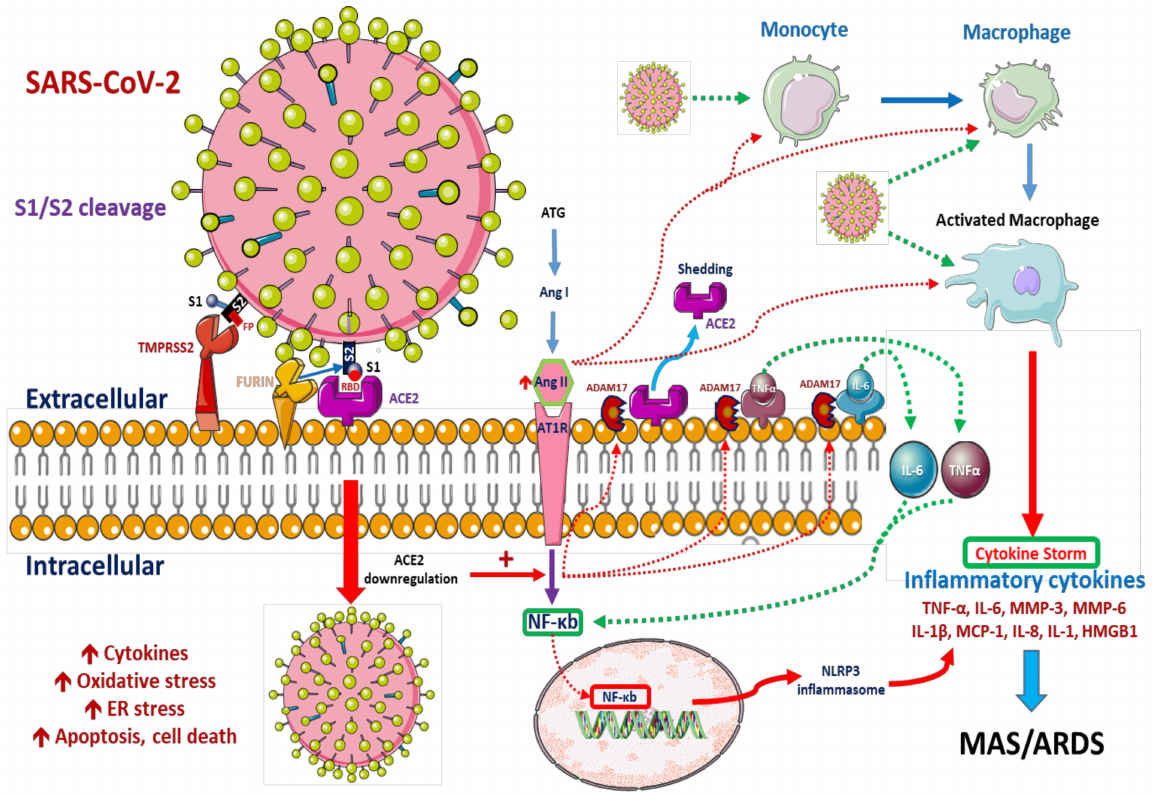
Figure 1. Possible pathophysiological pathways after the entry of severe acute respiratory syndrome coronavirus 2 (SARS- CoV-2). SARS-CoV-2 infects both alveolar macrophages and type II alveolar cells by binding to angiotensin-converting 2 (ACE2) receptors. Before SRAS-CoV-2 enters the host cells, the spike protein 1 (S1) should be pre-activated by the host furin, a convertase proprotein, which will expose the receptor binding domain (RBD) of S1. RBD has a strong binding affinity for the host cell membrane ACE2 for effective entry. After binding of RBD and ACE2, the type 2 transmembrane protease (TMPRSS2) will proteolytically activated the S1/S2 boundary through cleavage the S1–S2 protein which will cause drastic structural changes with further expose the fusion peptide (FP) of S2 which will facilitate the processing of viral-host cell fusion [44]. Immediately after entry, S protein activation is mediated by lysosomal cathepsins and/or furin within the TGN [14,15]. SARS-CoV-2 replication is suppressed by synthetic furin inhibitors [16]. After entry into the host cell, the virus downregulates ACE2 expression, which in turn upregulates angiotensin II (Ang II). Ang II interacts with its receptor, Ang II receptor type 1, and modulates the gene expression of several inflammatory cytokines via nuclear factor κ B signaling. This interaction also promotes macrophage activation and results in the production of inflammatory cytokines that may cause acute respiratory distress syndrome or macrophage activation syndrome. Some metalloproteases, such as ADAM metallopeptidase domain 17, cleave these pro-inflammatory cytokines and ACE2 receptors, resulting in their release as soluble forms. This contributes to the loss of the protective function of surface ACE2 and potentially exacerbates SARS-CoV-2 pathogenesis [39]. Monocytes and macrophages in the mononuclear phagocyte system, infected with SARS-CoV-2, produce various pro-inflammatory cytokines and chemokines, a process critical for the induction of local and systemic inflammatory responses known as cytokine storms